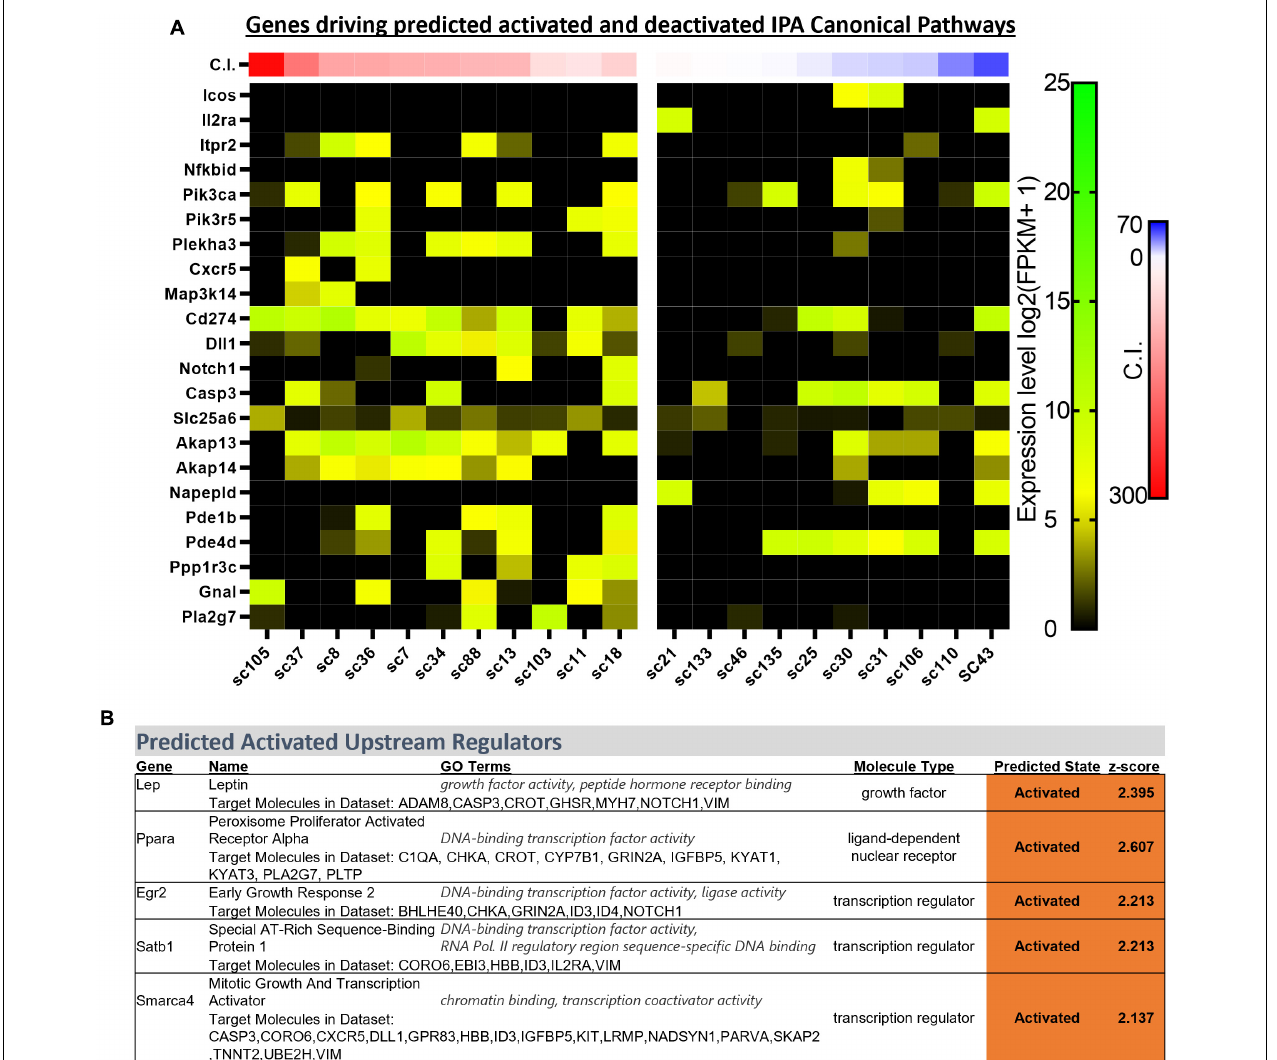
FIGURE 5 | Heatmap of gene expression for each DEG contributing to activated z-scores across identified ingenuity pathway analysis (IPA) canonical pathways (indicated in the text) across all sequenced cells categorized by chemosensitivity index (C.I.) (A) . IPA predicted activated upstream regulators of 166 DEGs indicate Egr2 and Lep , among others, as activated in CO 2 sensitive 5-HT neurons (B)